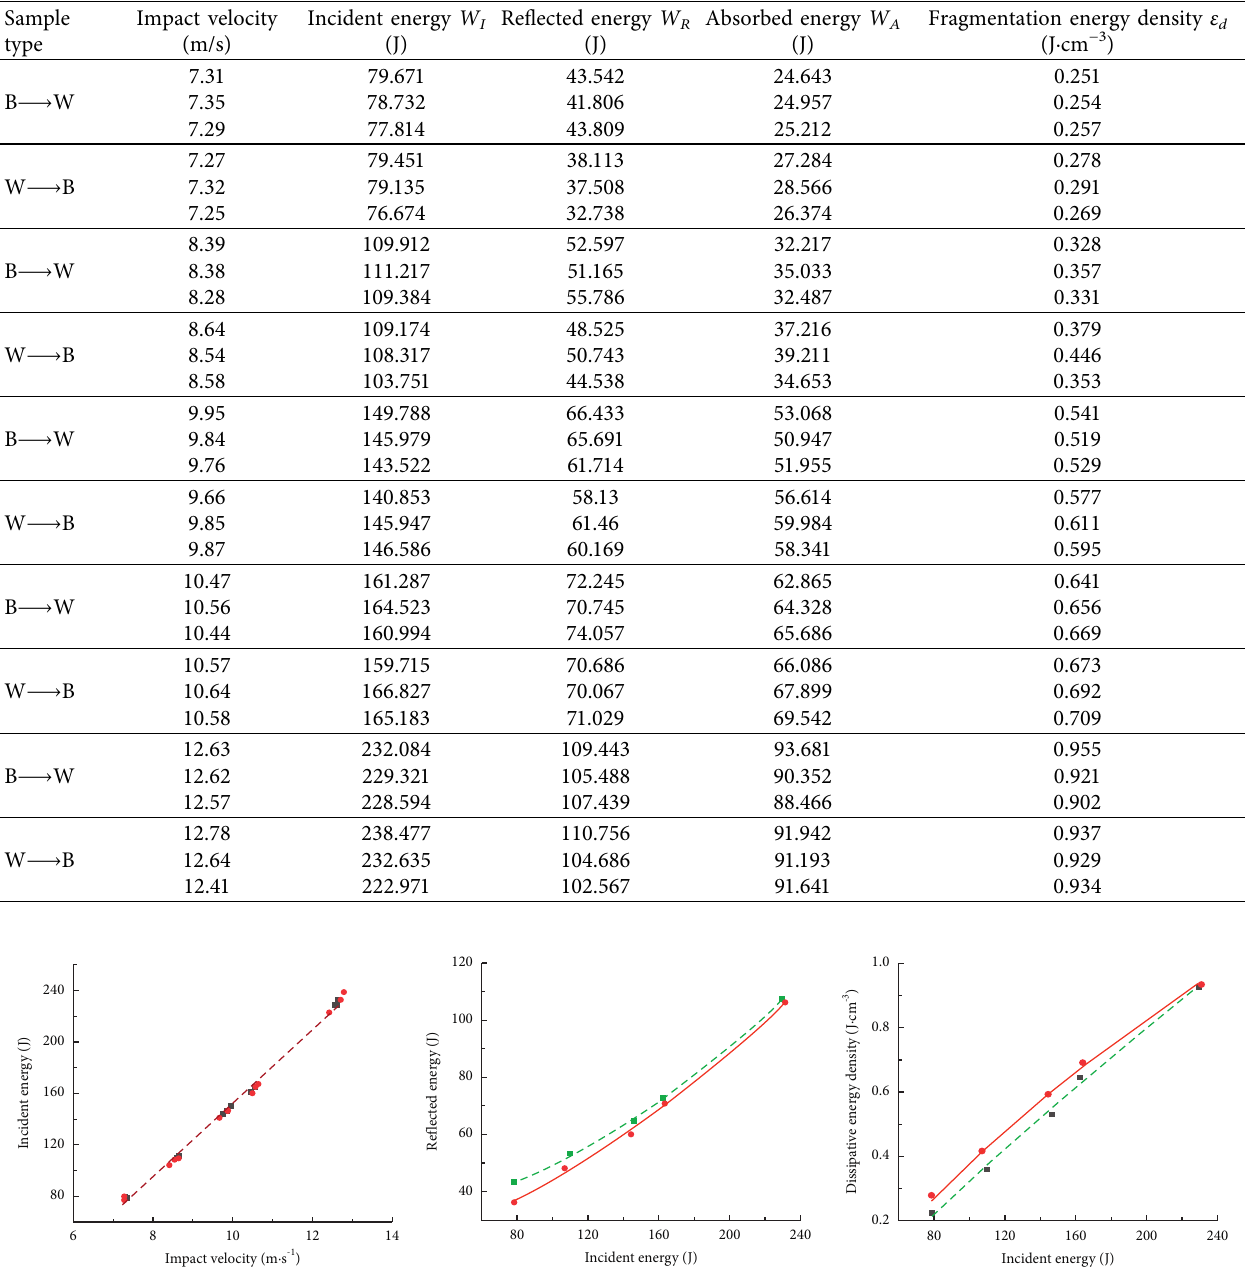
Table 2: Energy distribution of layered composite rock mass.